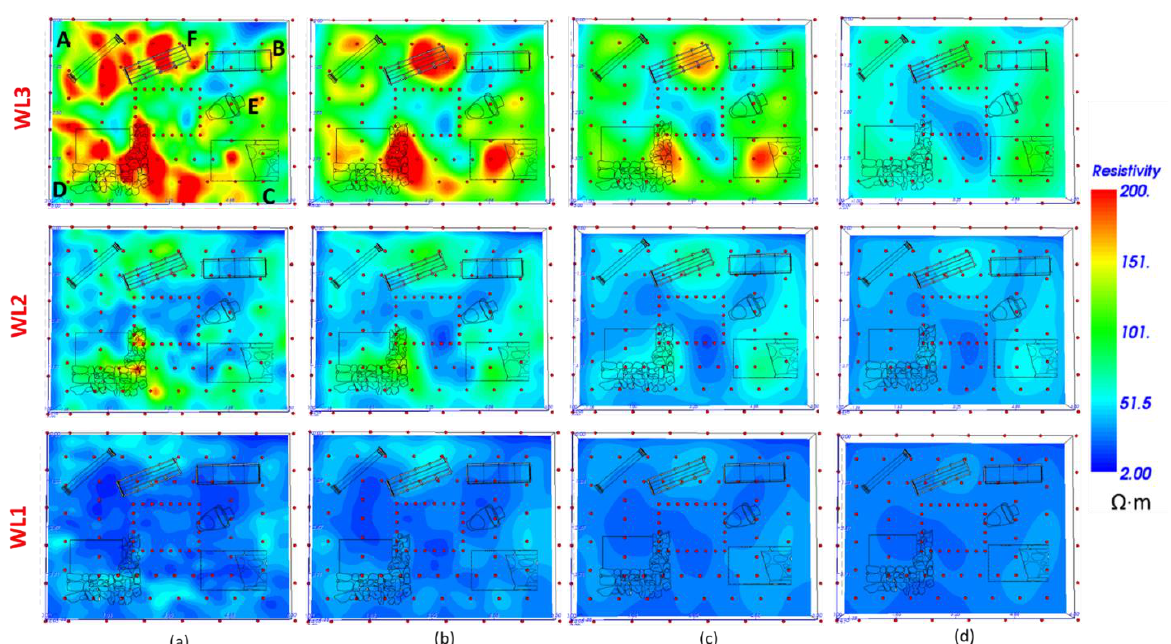
Figure 19. Comparison of GPR slices at the depths of 0.25 m ( a ), 0.45 m ( b ), 0.70 m ( c ) and 1.00 m ( d ) for the different scenarios in WP1.